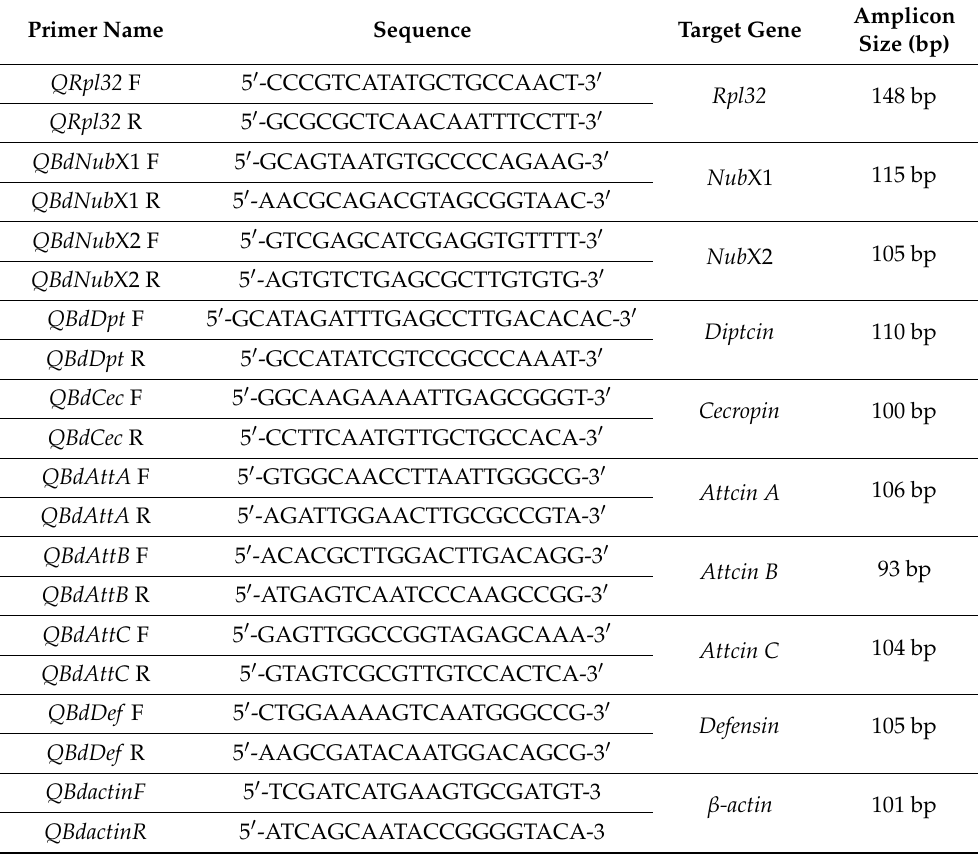
Table 1. The primers used for Quantitative Real-time